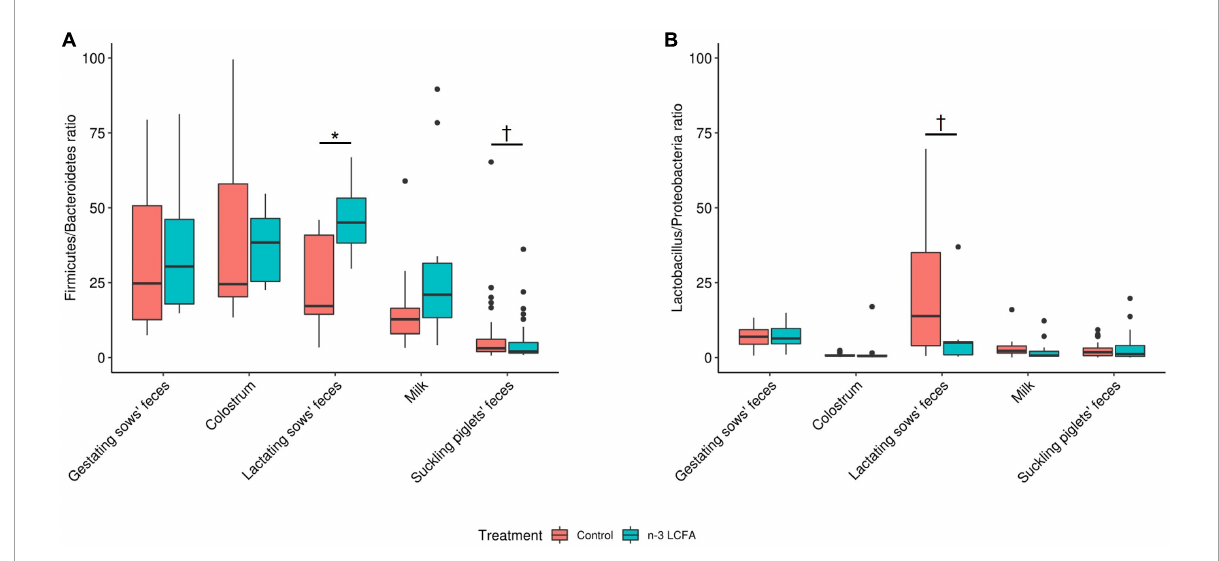
FIGURE4 Firmicutes/Bacteroidetes (A) and Lactobacillus /Proteobacteria (B) ratios calculated between treatments in all sample types. For feces of gestating and lactating sows, colostrum, and milk; n = 11 for control and n = 10 for n-3 LCFA. For feces of suckling piglets; n = 44 for control and n = 40 for n-3 LCFA. Significant differences between treatments were set at P < 0.05 (*), while tendencies were set at P < 0.10 ( † ). Ratios were adjusted at a maximum value of 100 and higher values were removed by being considered outliers. LCFA, long-chain fatty acids.